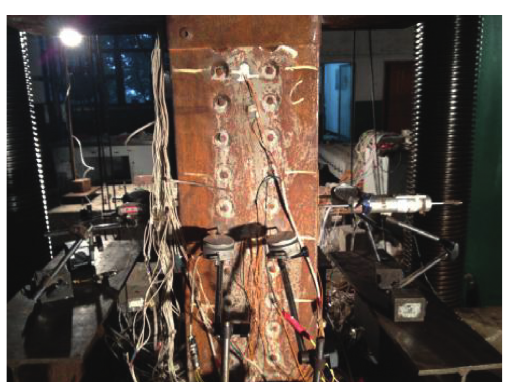
Figure 5: The specimen is inclined to the B